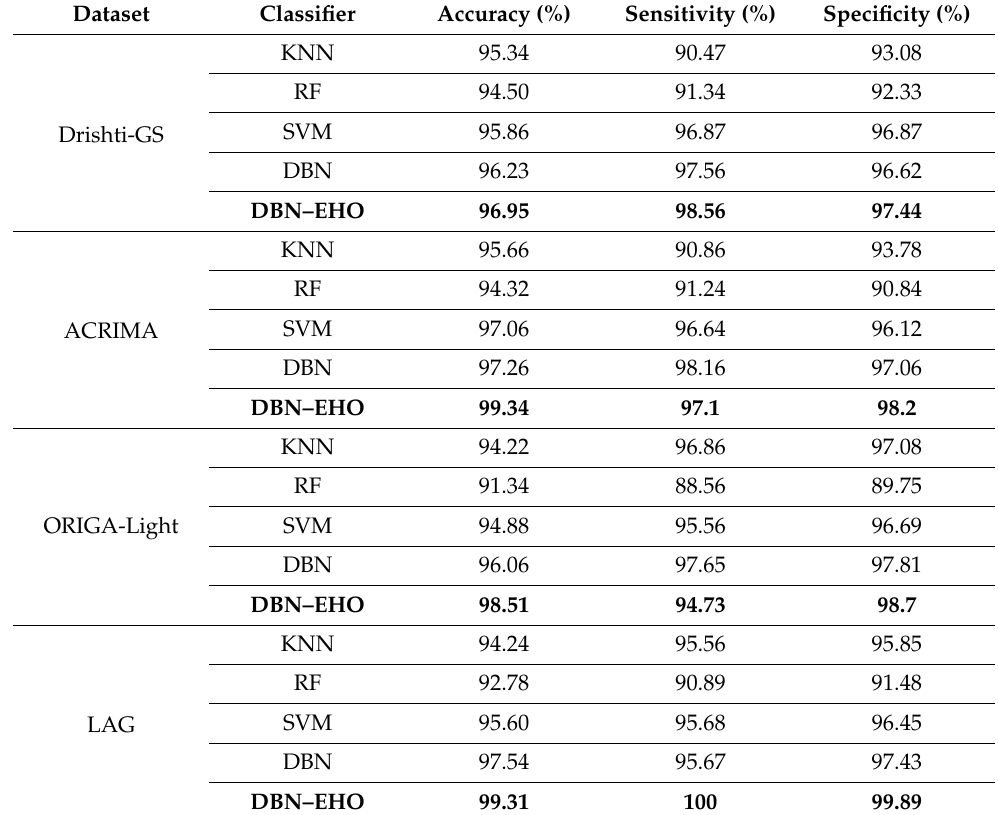
Table 9. Performance analysis with dissimilar